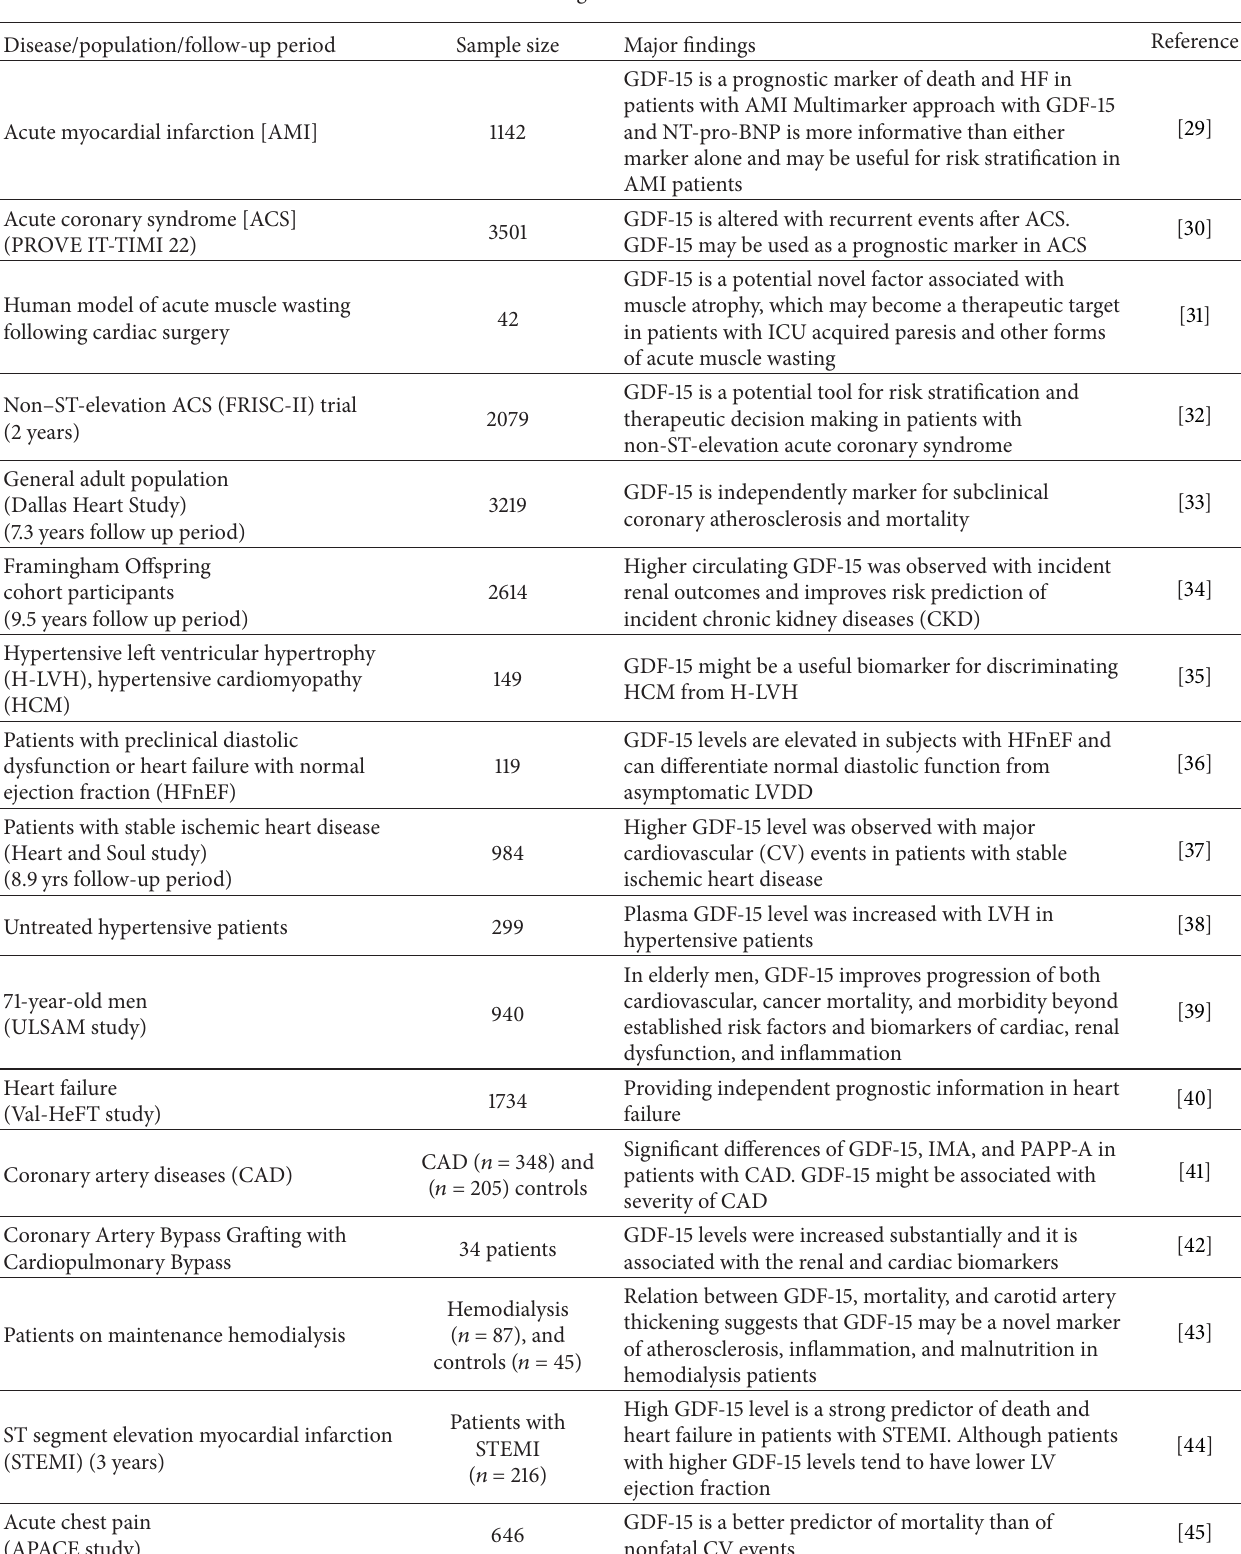
Table 2: List of human studies dealing with GDF-15 levels in cardiovascular